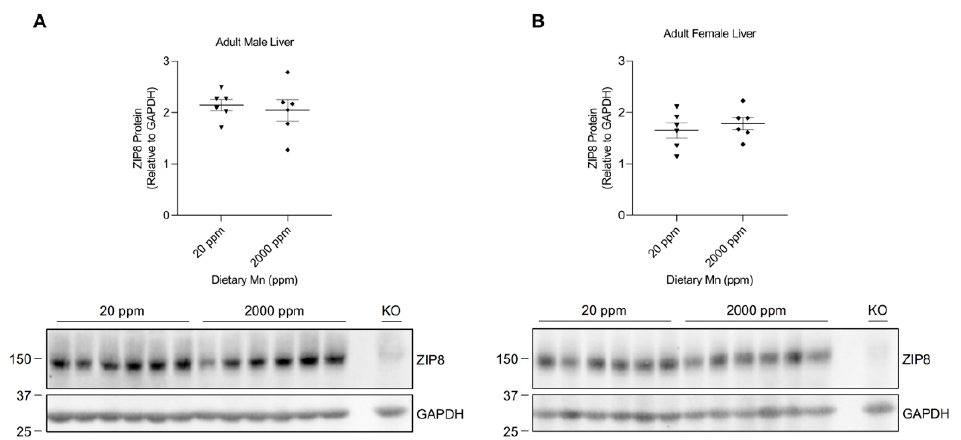
Figure 5. Comparison of liver ZIP8 levels between the control and high-manganese diet groups. Expressions of ZIP8 in male ( A ) and female ( B ) pups that were born from and fed by mothers on 20 ppm manganese and 2000 ppm manganese diets were compared ( n = 3–4/group). Liver samples were collected from pups at 3 weeks of age for Western blot analysis. Equal amounts of protein (213 µg for male liver samples and 240 µg for female liver samples) were loaded per lane. Blots include the liver sample from a female, 6-week-old Zip8 -KO mouse (fed a traditional rodent diet) as a control. Quantification of ZIP8 levels were determined using GAPDH as the loading control. Data are expressed as mean ± SEM. ** p < 0.01, *** p < 0.001.